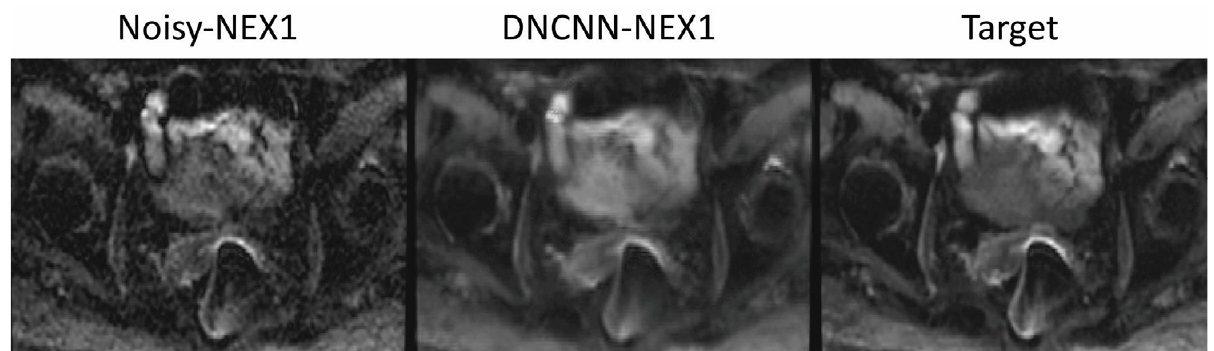
Figure 7. Patient with gas in the rectum that presents strong distortion artifacts. The DCNN-NEX1 (16-fold acceleration) presents improved image quality to the conventional reconstruction without denoising and similar image quality to the target with NEX = 16, despite the high acceleration. Table 3 shows the results of the reader study to denoise high b -value images acquired with NEX = 1, 2, and 4 (acceleration factors of 16, 8, and 4, respectively). Overall, the de- noised images received higher scores than the noisy images. Among different acceleration factors, images with 4-fold acceleration (NEX = 4) received the highest scores. Denoised images with 4-fold acceleration even received higher scores than the reference images. For example, in the overall image quality category, denoised images with NEX = 4 received a median score + interquartile range (IQR) of 3 ± 0.6 from reader 1, which means 50% of the scores spread from 2.4 to 3.6 in a 1–4 scale, and 3 ± 0.5 from reader 2, reference images (NEX = 16) received scores of 3 ± 1 from reader 1 and 2 ± 0.5 from reader 2. Reader 1 scored similar overall image quality (2.5 ± 0.5 on a 1–4 scale) between 16-fold (NEX = 1) and 8-fold (NEX = 2) accelerations, which were slightly lower than the reference (3.0 ± 1.0). Reader 2 scored similar quality between NEX = 1 and the reference (2.0 ± 0.5 for both), while better quality for NEX = 2 (3.0 ± 0.5). Table 3. Qualitative image qualitative evaluation was performed by two expert radiologists. Median ± IQR scores are shown for each reader and image quality category. Image Rectum Margin and Rectal Noise Image Quality Wall Layers Demarcation Suppression